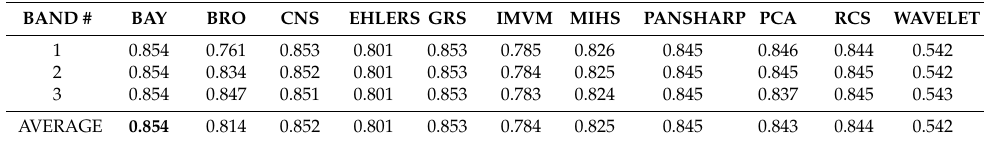
Table 1. Spatial consistency: correlation coe ffi cient (CC) Laplacian filtering. Abbreviations: Bayesian fusion (BAY); Brovey transform(BRO); Color Normalized Spectral sharpening (CNS); Ehlers fusion technique (EHLERS); Gram–Schmidt (GRS); Local Mean and Variance Matching (IMVM),